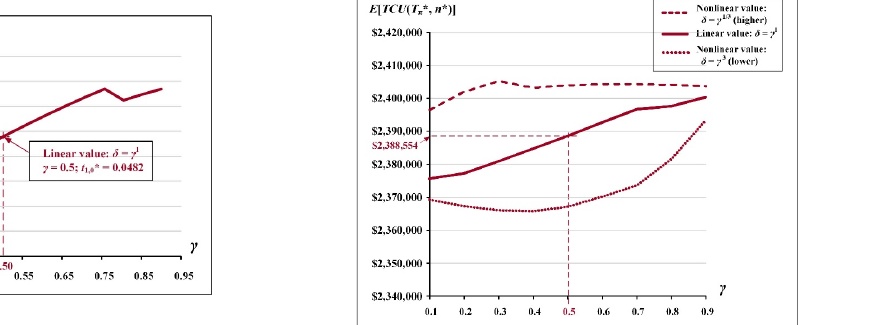
Fig. 14. The optimal standard component’s uptime t 1,0 * relating to γ